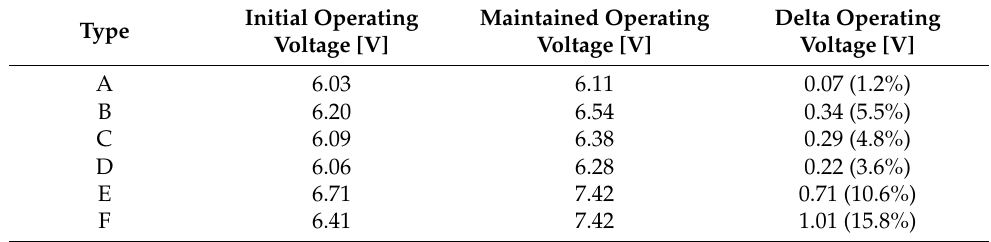
Table 7. Operating voltage maintenance characteristics of OLED products after aging of 6000 h.